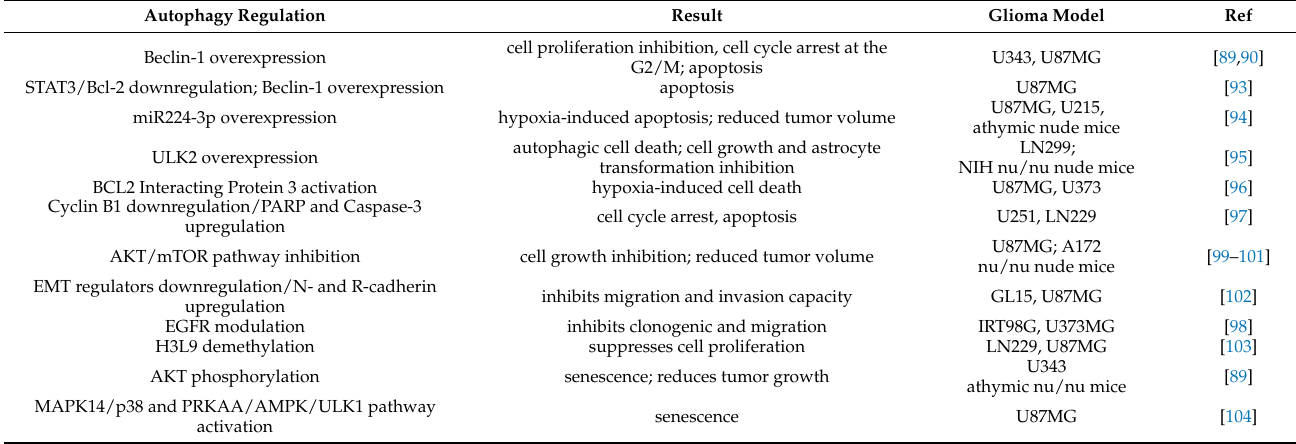
Table 2. Autophagy regulation suppresses